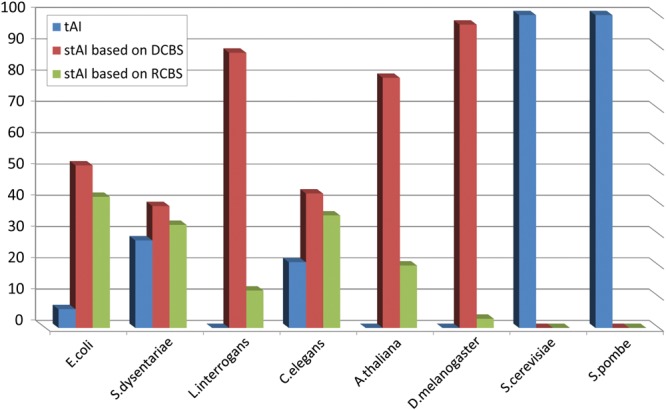
Comparison between stAI and the tAI. The middle bars representing the number of times (based on the jack-knifing analysis) the stAI outperformed the other versions of the tAI; as can be seen, stAI outperforms tAI in all non-fungal organisms.